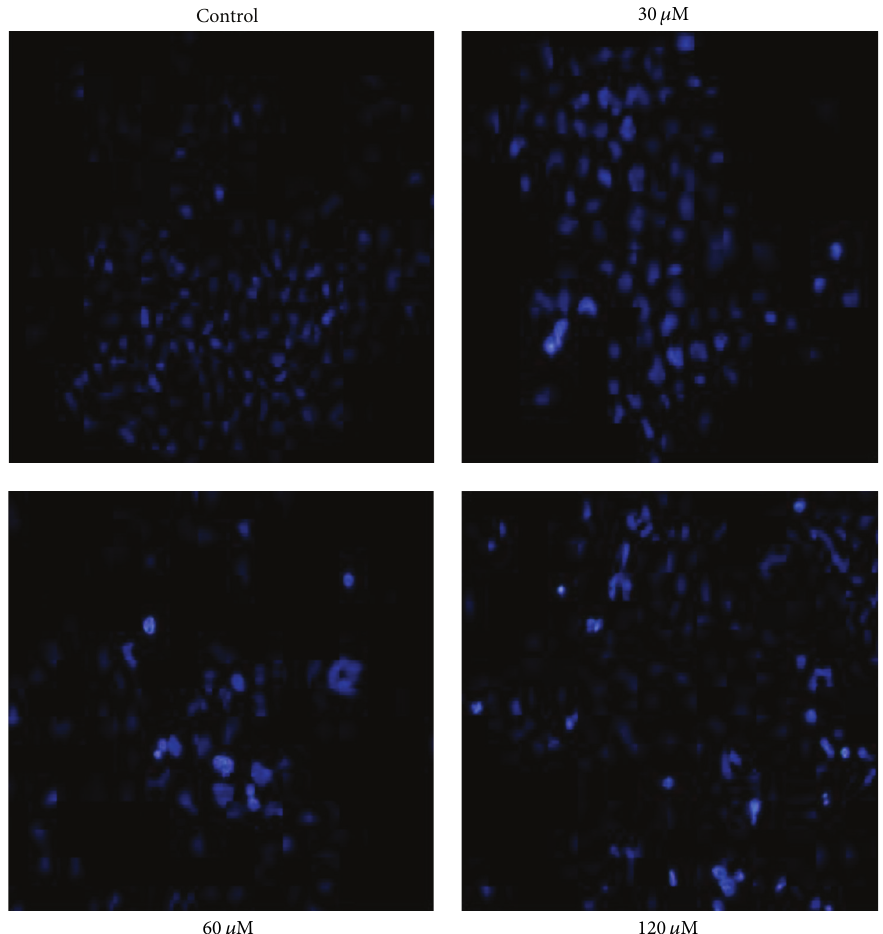
Figure 7: Effects of complex 1 on the morphology of Bel-7402 cells were assayed by Hoechst 33342 staining. After treatment with complex 1 for 48h, apoptotic cells were detected by Hoechst 33342 staining and examined by fluorescence microscopy (original magnification 400x).